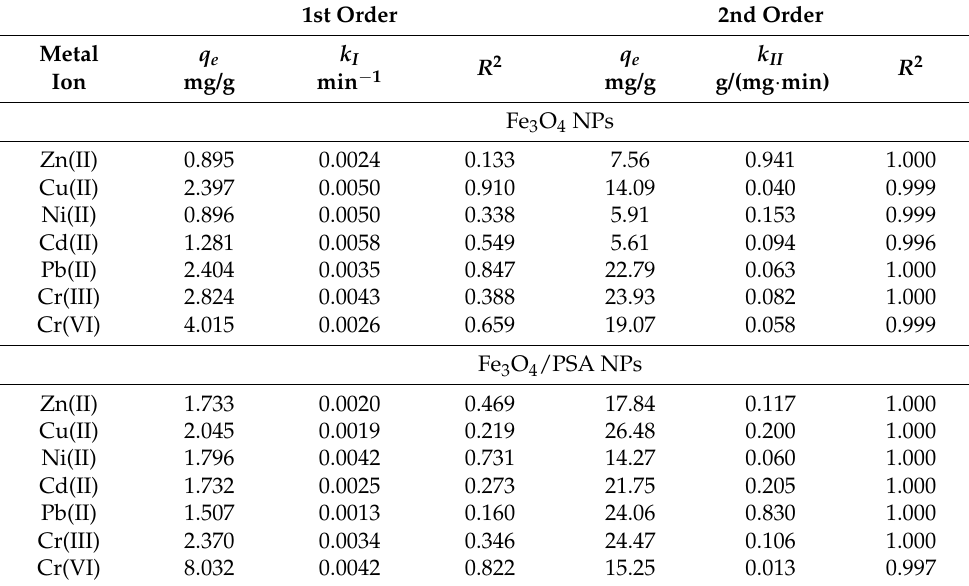
Table 2. Parameters of the applied kinetic